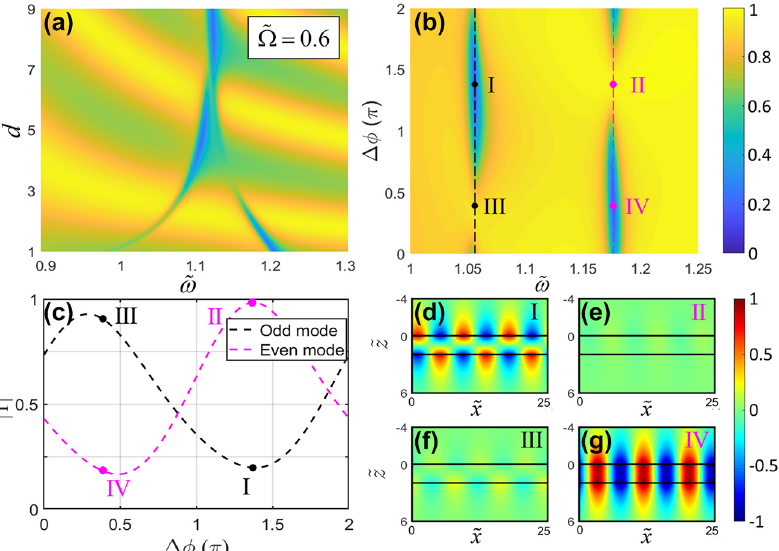
Figure 3: The surface modes excitation of the DFS system with phase modulation. (a) Transmittance spectra of the DFS structure without phase modulation as a function of incident frequency ̃𝜔 and interlayer distance Contour plots of the transmittance spectra as a function of incident frequency ̃𝜔 and phase difference Δ 𝜙 . The positions of the black and magenta vertical-dashed lines represent the two resonance frequencies in Figure 2b, and the four dots highlight the maximum and minimum values of the transmittance, labeled as I, II, III, IV, on the black and magenta vertical-dashed lines. (c) Transmittance through the DFS for the cases of efficient excitation of the odd (anti-symmetric) and even (symmetric) modes at the respective resonant frequencies (corresponding to the black and magenta vertical-dashed lines in (b)), as a function of the phase difference Δ 𝜙 . (d–g) amplitude distributions of electric ( ) ̃ E field corresponding to the four dots marked in x , − 1